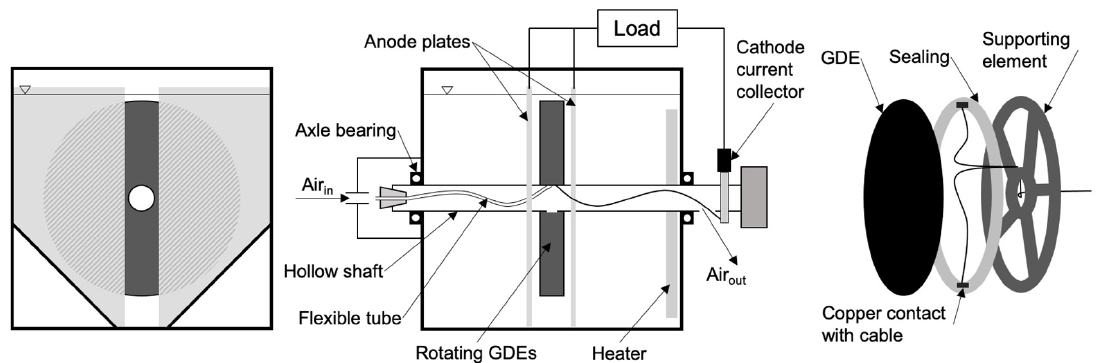
Figure 1. Schematic of reactor design. Table 2. Configuration of the investigated reactors.